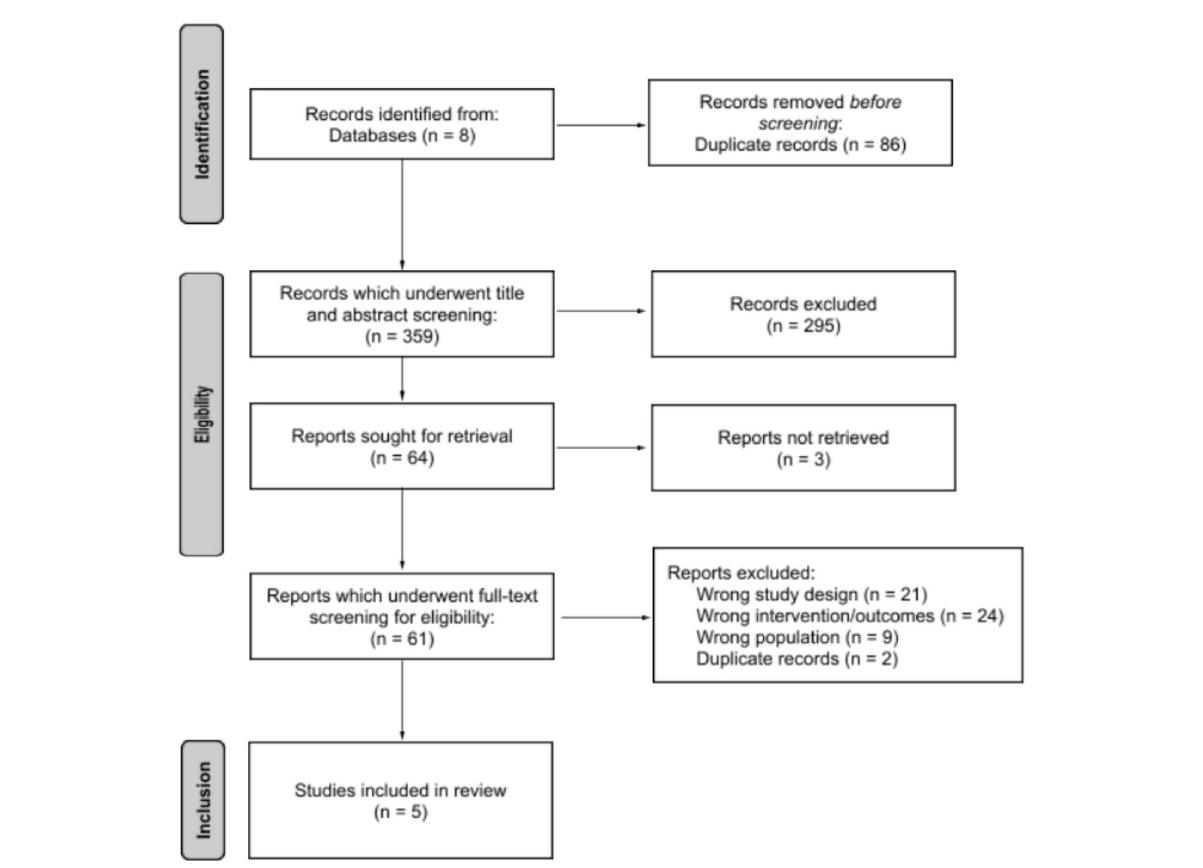
FIGURE1 Systematic literature eligibility results for the perspectives and experiences of Indigenous peoples in Canada with autism and dis/ability. Adapted from: Page